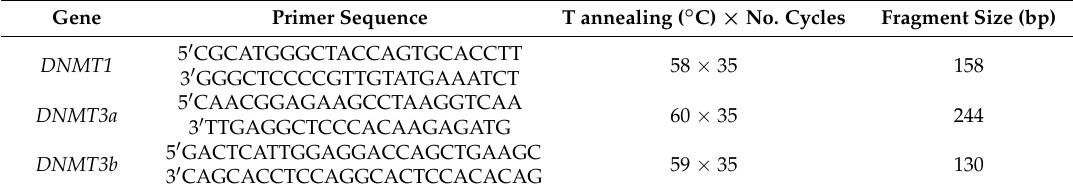
Table A1. Number of COCs used per group for different tests ( n = 9). Groups